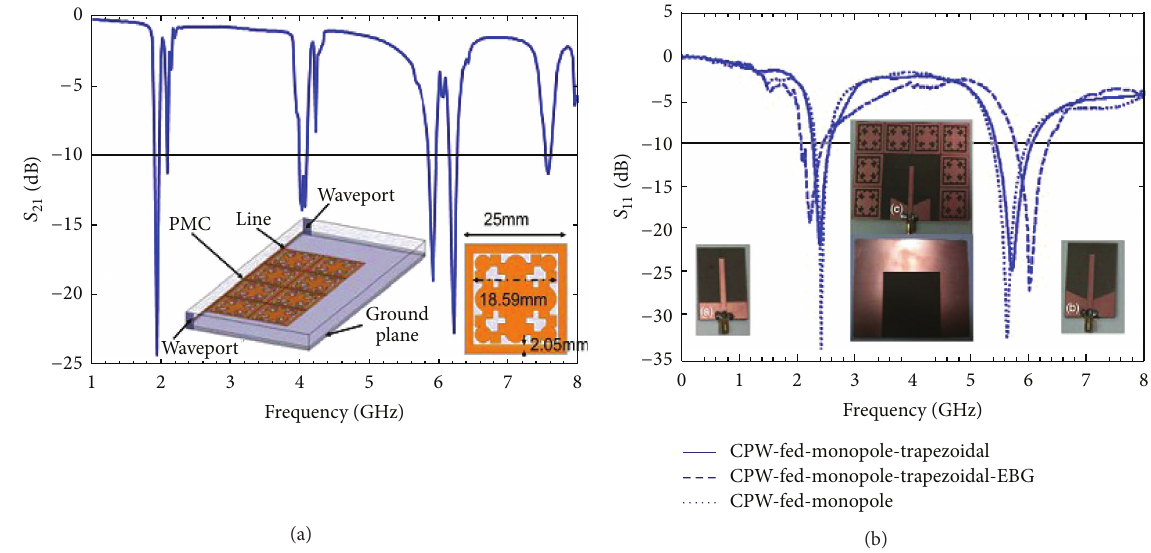
Figure 22: (a) Simulated band gap for a 4 × 4 EBG array (b) Measured return